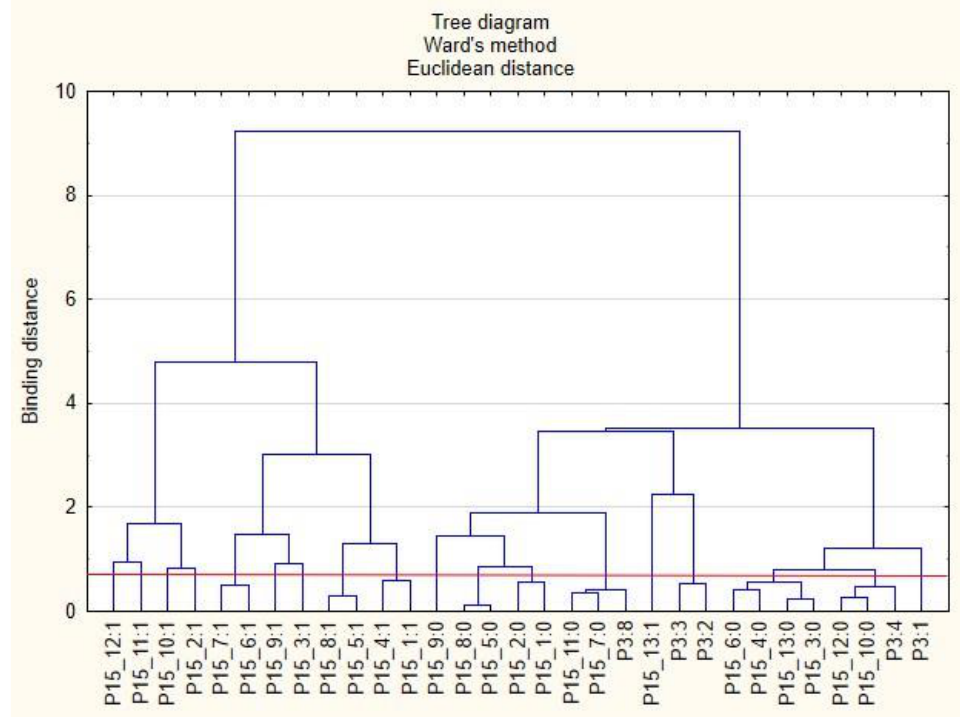
Figure 2. Diagram of hierarchical classification of variable categories: support received during the COVID-19 pandemic from the employer in the area of health care and the effective use of the benefits offered (P15) as well as the professional situation of the respondents (P3).